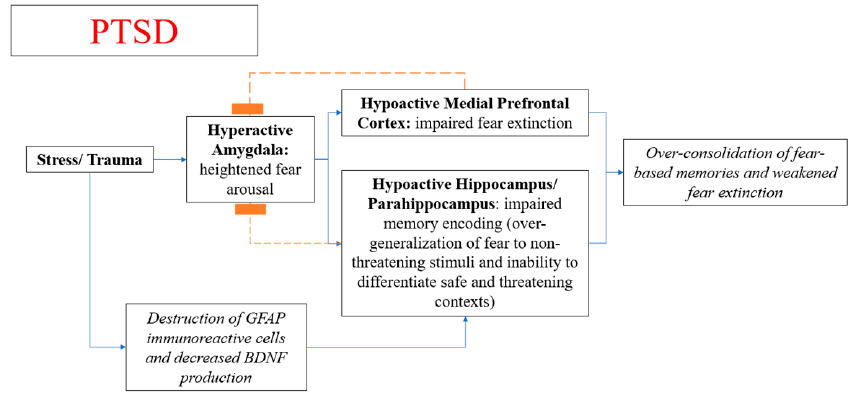
Figure 2. Abnormalities in consolidation of fear memory and extinction of fear memory in individuals with PTSD.